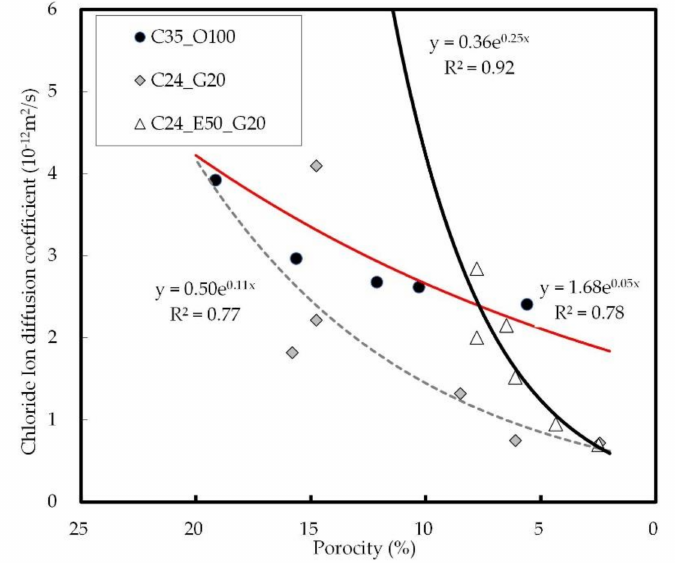
Figure 16. Relation between internal porosity and chloride ion diffusion coefficient on